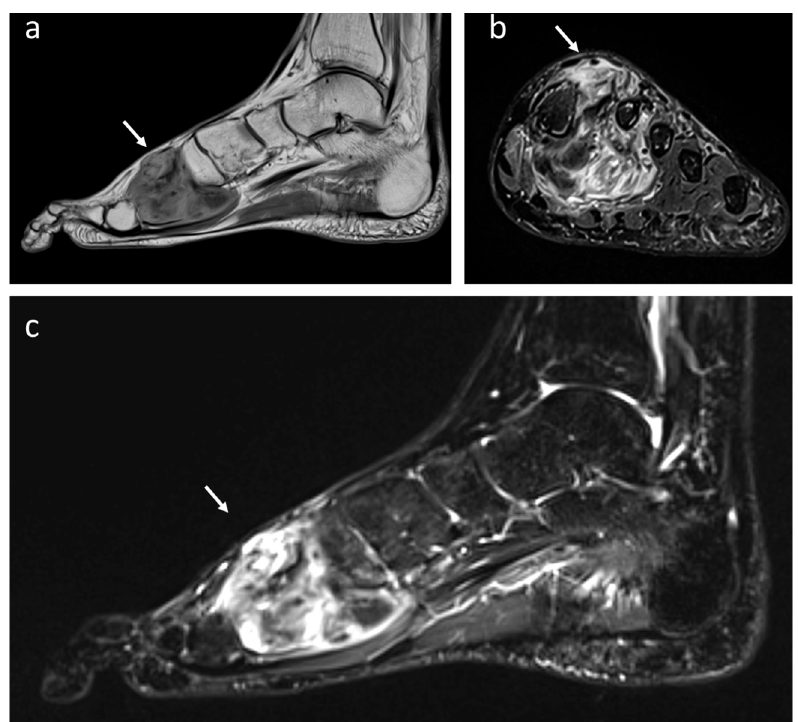
Figure 6. Synovial monophasic Sarcoma of deep foot soft tissues (white arrows) in a 49-year-old male patient: ( a ) T1-weighted MRI showing heterogeneous multiloculated mass isointense to muscle in sagittal projection while an increased signal intensity is shown at T2 STIR in coronal ( b ) and sagittal projection ( c ).